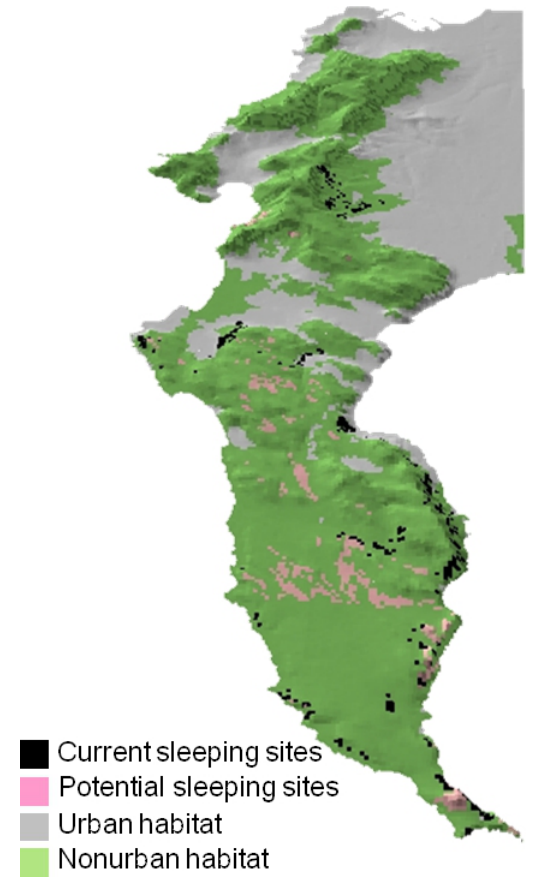
Fig. 3 . A three-dimensional habitat map showing the distribution of grid cells currently used as sleeping sites (black) and grid cells not used as sleeping sites (pink) that are ‡ 500 m from the urban edge and which match the characteristics of used cliff sleeping